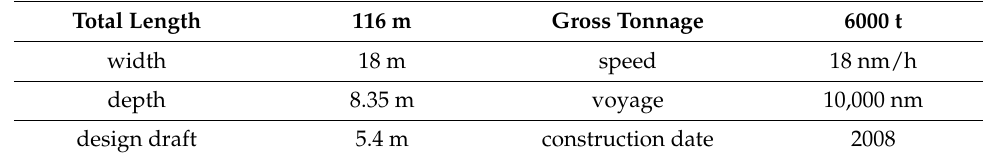
Table 7. The specific parameters of test ship named